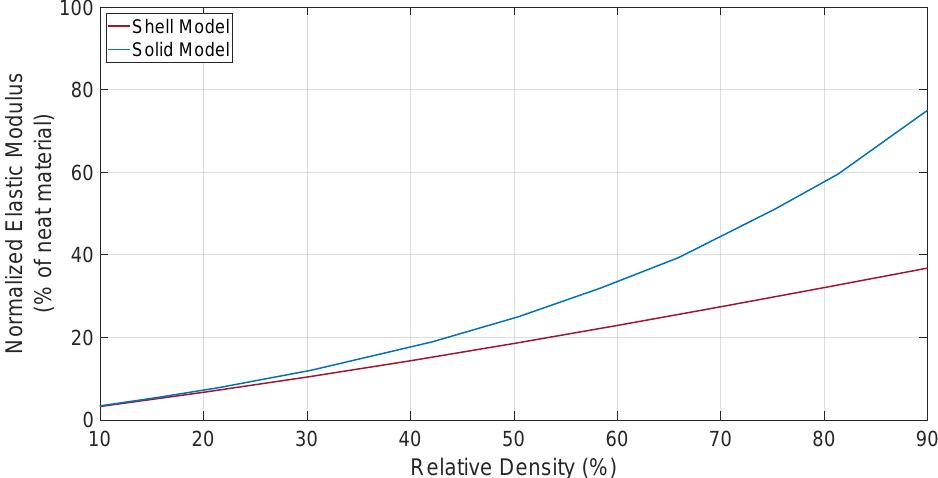
Figure 9. Comparison of the normalized elastic moduli from the shell and solid